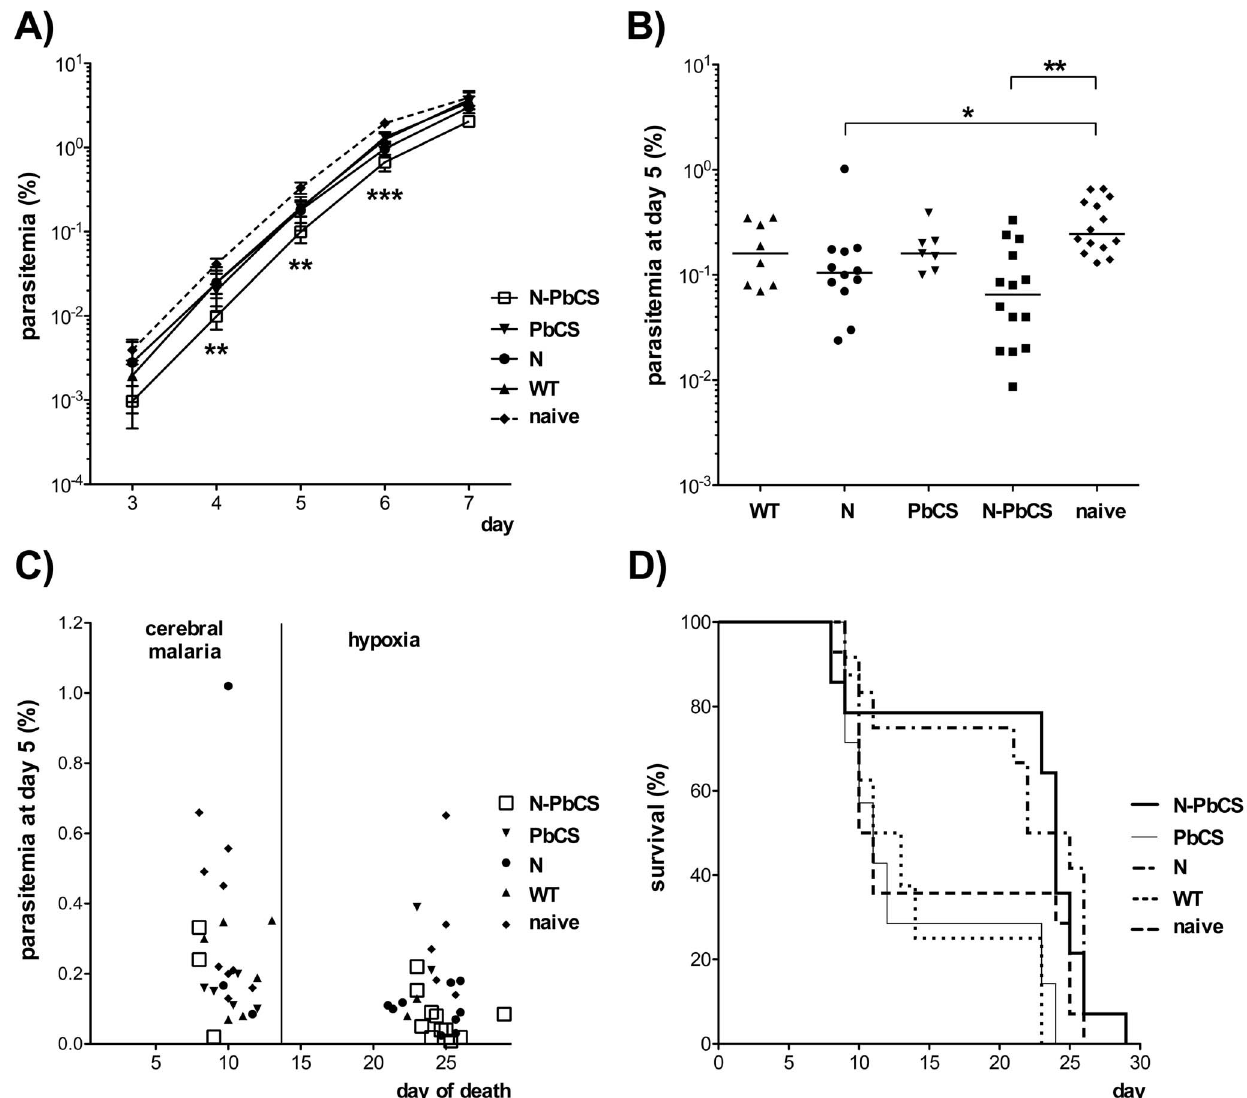
Figure 8. Experimental challenge of immunized mice. ( A ) Mean and standard deviations log 10 values of parasitemia in mice immunized by N- PbCS, PbCS, N or WT yeast, and in non-immunized mice following infection with 6,000 GFP + Pb sporozoites. Blood parasitemia is expressed in log 10 scale as the percentage of infected red blood cells (iRBCs) out of total RBCs along the first 7 days follow up. Asterisks (*) indicate the significance level of the Mann-Whitney nonparametric test: two symbols correspond to p , 0.005 and three to p , 0.0005. ( B ) Parasitemia at day 5 post-challenge. Bars correspond to medians. Asterisks (*) indicate significant median differences (one symbol for p , 0.05 and two for p , 0.005; Mann-Whitney nonparametric test). ( C ) Inverse correlation between the day of death (x axis) and the percentage of iRBCs per total RBCs (y axis; arithmetic scale) per mouse. The cause of death is given in the upper part of the graph. ( D ) Survival curves of immunized mice after challenge with 6,000 GFP + Pb